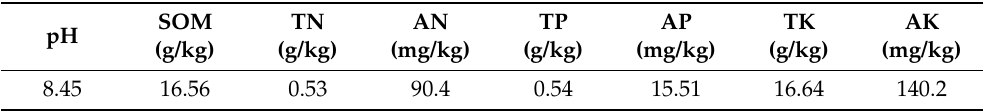
Table 1. Basic characteristics of the tested